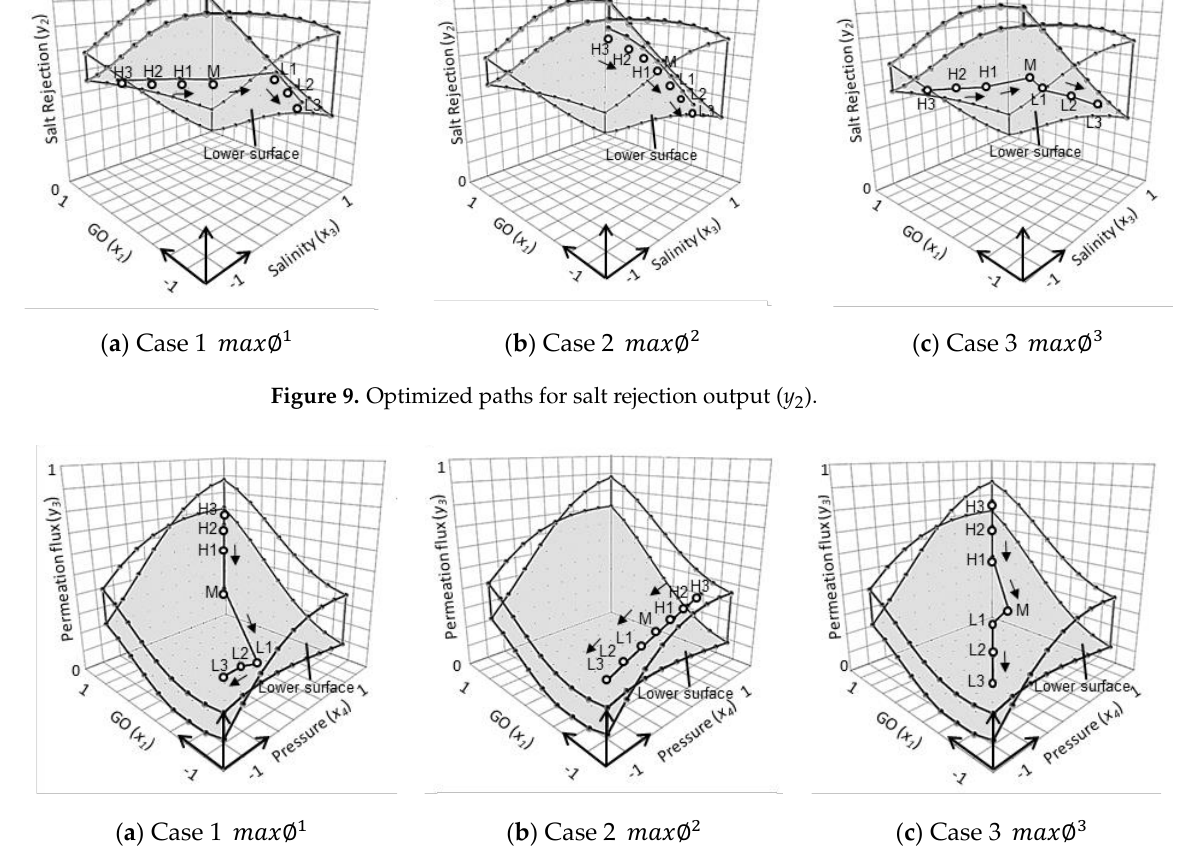
Figure 10. Optimized paths for permeation output ( y 3 ).